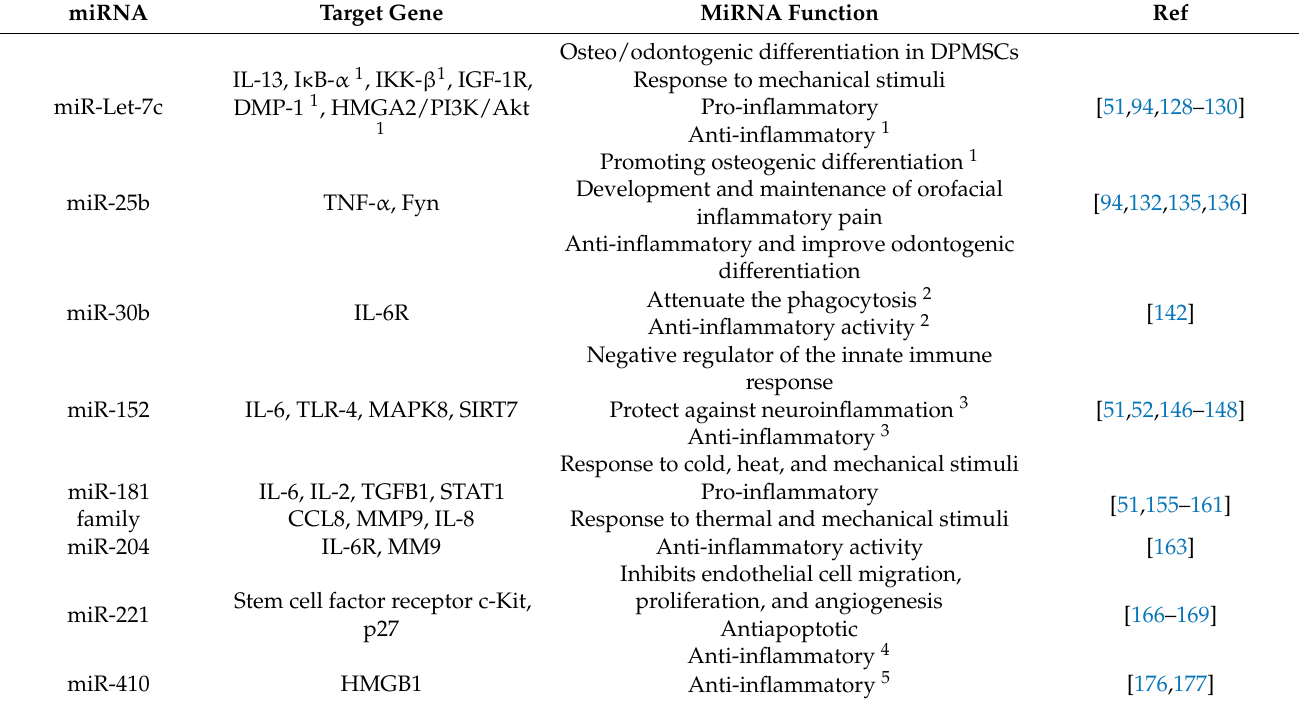
Table 2. Downregulated miRNAs in pulp